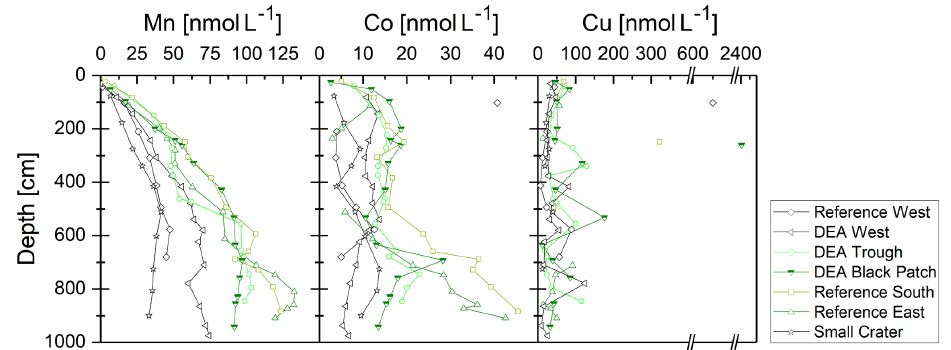
Figure 7. Dissolved Mn, Co, and Cu concentrations in the porewater of the sediment cores. No porewater could be extracted from buried nodules.